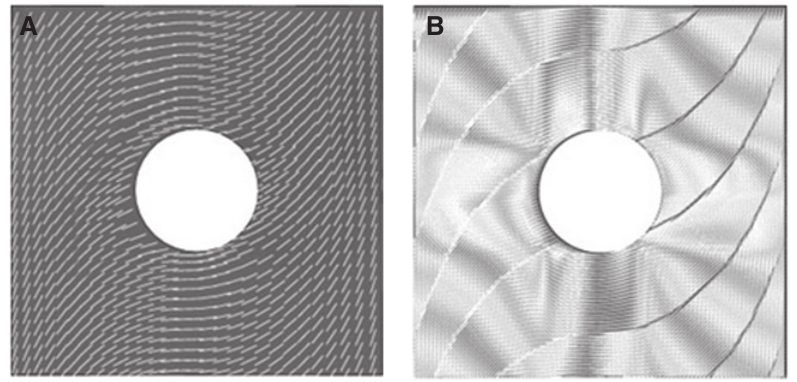
Figure 7: Fiber orientation on ideal and manufacturable tow-steered plies with a central hole. Reproduced from Lopes et al. [122]. (A) Ideal ply. (B) Manufacturable